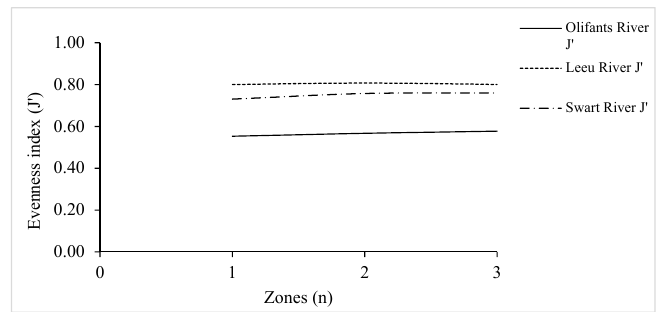
Figure 4. Evenness curves for Olifants (solid line), Leeu (dotted line) and Swart (solid-dotted line) rivers in Western Cape, South Africa. Evenness index was the highest along the Leeu riparian zone.